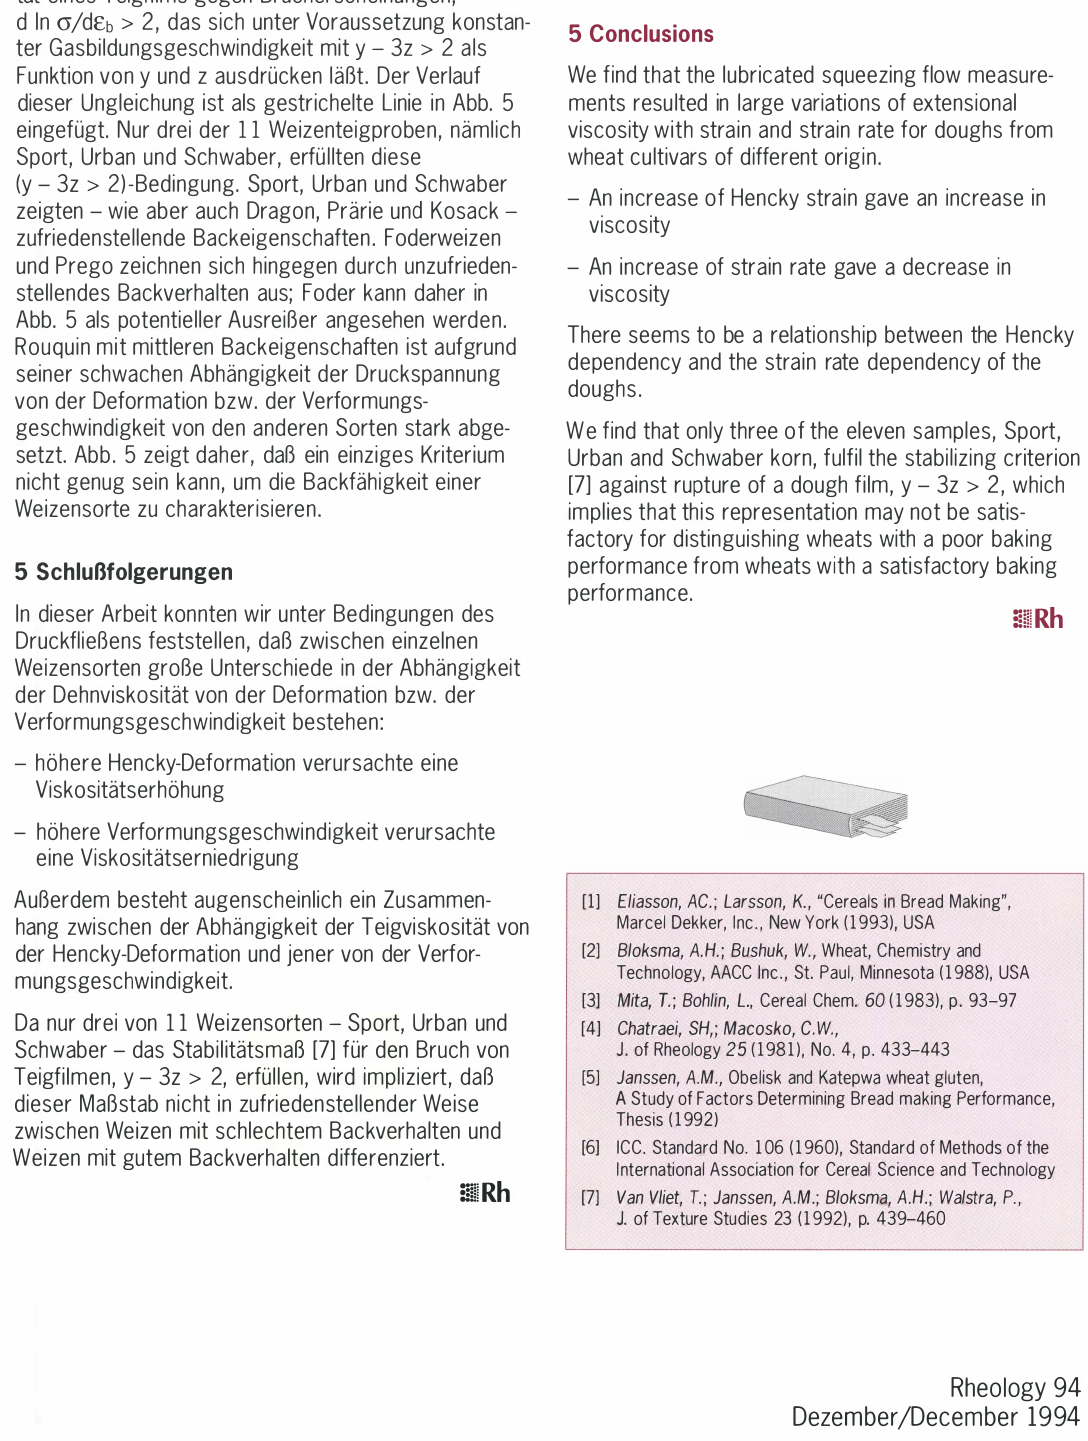
was offset largely from the others showing weak stress dependency on strain and an almost linear dependence of stress on the strain rate. The results from fig. 5 show that one single criterion is not enough to characterize the baking performance of a wheat